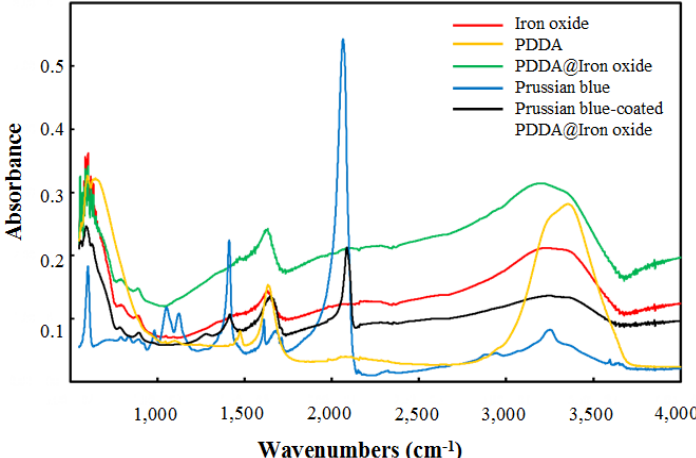
Figure 3. Fourier-transform infrared (FTIR) spectra of the synthesized materials.